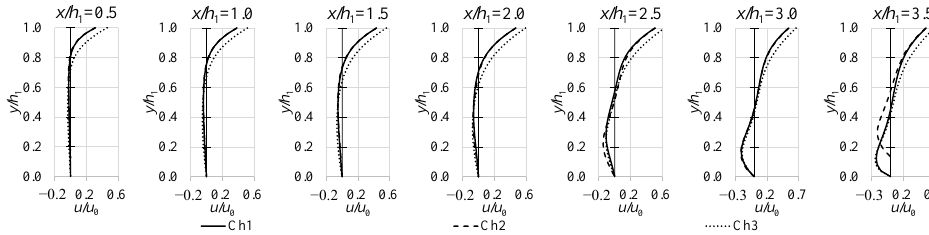
Figure 9. Velocity u profiles in Ch1, Ch2 and Ch3 at Re = 1000.